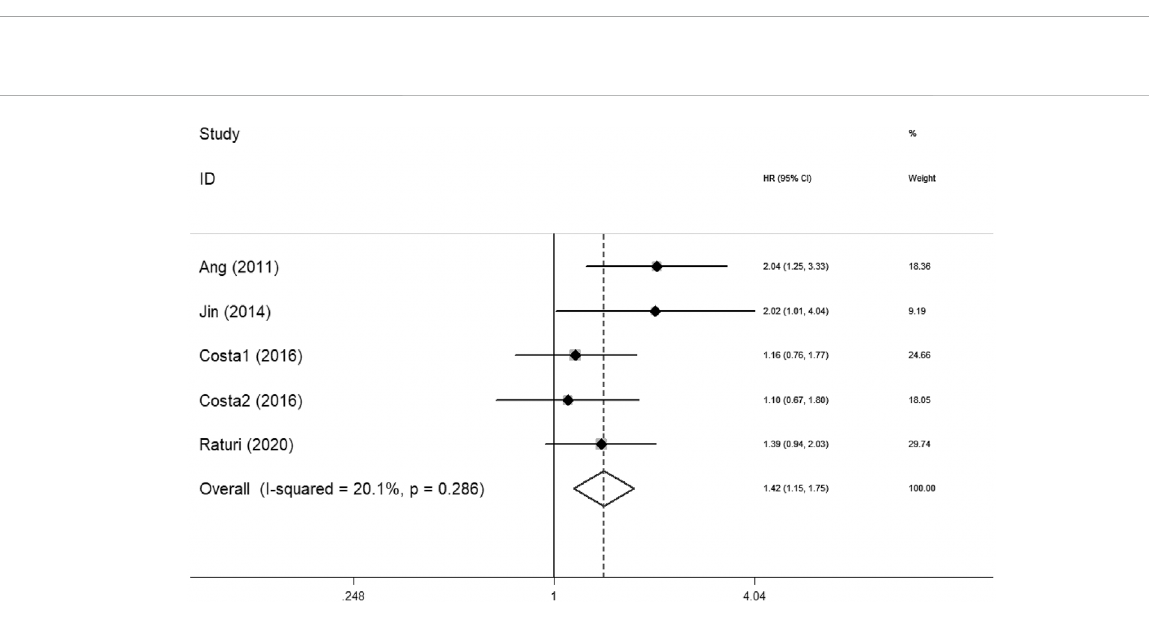
FIGURE 2 Forest plot indicating the overall survival association between XRCC1 gene polymorphisms (Arg194Trp and Arg399Gln)/high XRCC1 protein expression and HNSCC.